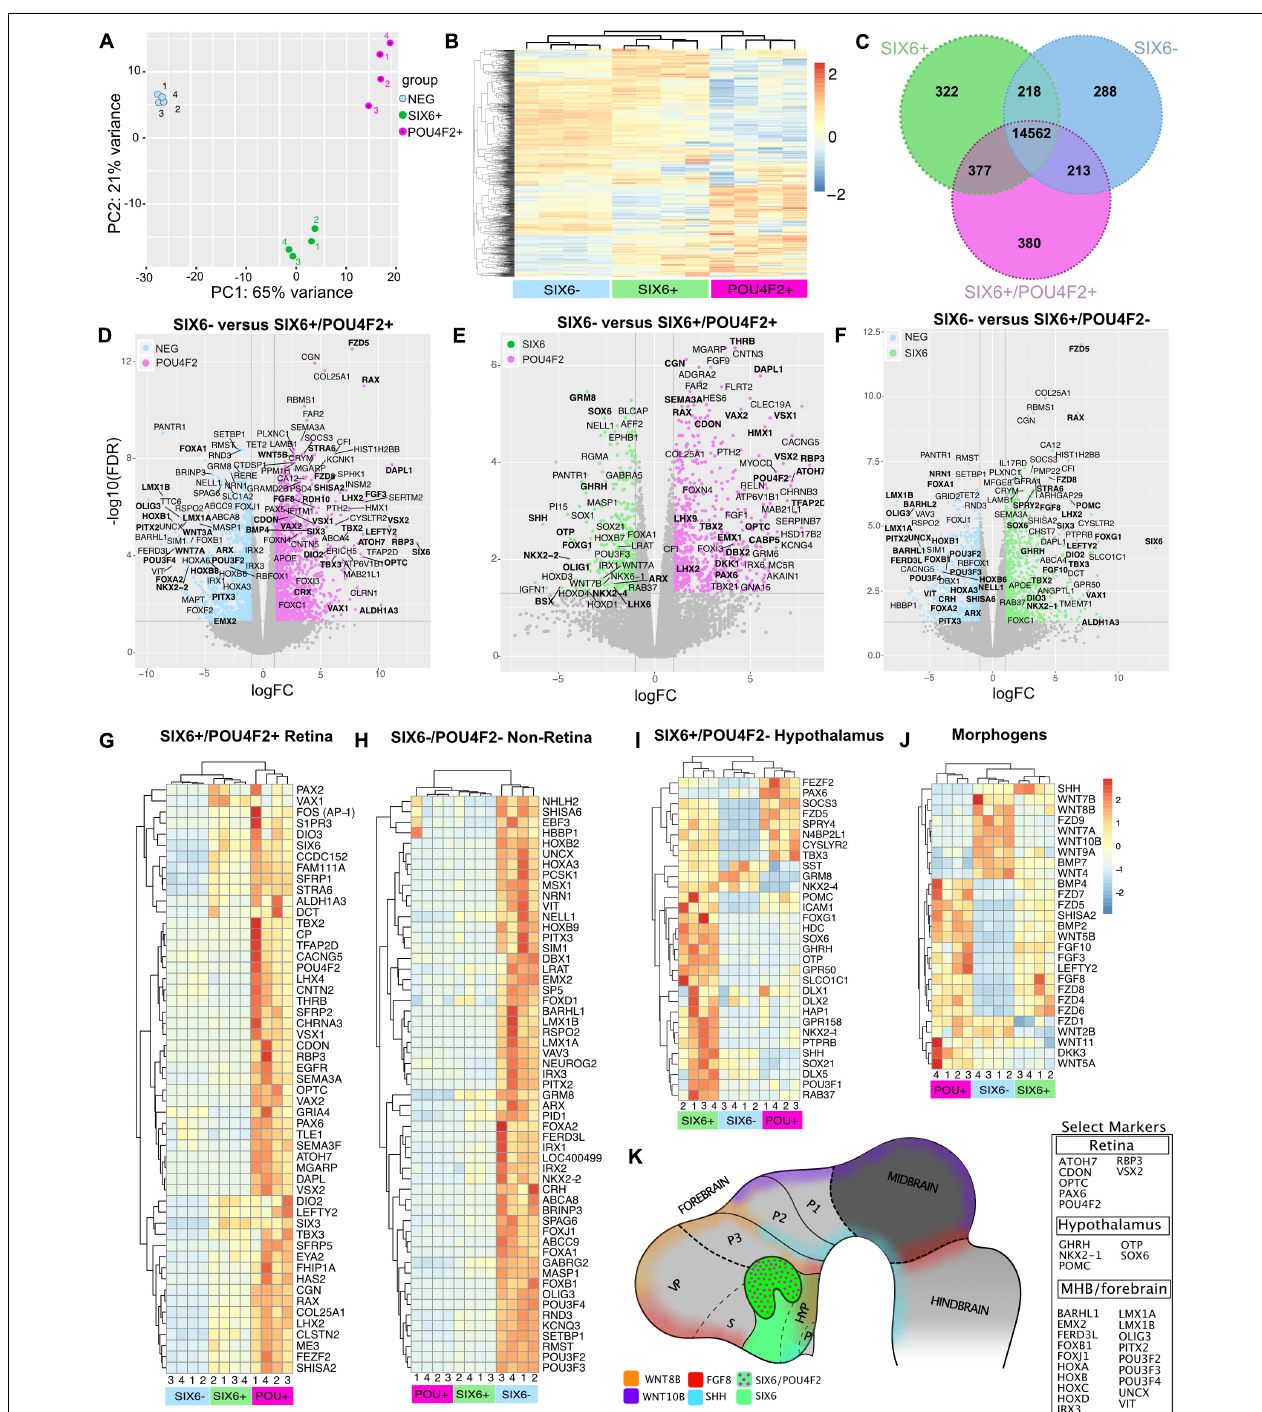
FIGURE 7 | Gene expression signatures in SIX6-, SIX6 +, and SIX6 + /POU4F2 + organoids after 65 days. (A) A PCA plot showing clustering within organoid types. (B) A heatmap of the top 1,000 expressed genes in SIX6 + /POU4F2 + organoids compared with SIX6 + /POU4F2- and SIX6- organoids. (C) A Venn diagram showing the intersection of significant genes expressed by organoid types. (D–F) Volcano plots of significantly different genes between (D) SIX6- and SIX6 + /POU4F2 + organoids, (E) SIX6 + /POU4F2- and SIX6 + /POU4F2 + organoids, (F) and SIX6- and SIX6 + /POU4F2- organoids. Differences plotted as logFC vs. -log10(FDR) with significance set as FDR < 0.5 and a FClog2 > 1. (G–J) Hierarchical clustered heat maps show genes enriched in (G) SIX6 + /POU4F2 + retina, (H) SIX6-/POU4F2- non-retina, (I) SIX6 + /POU4F2- hypothalamic organoids and (J) key developmental morphogens. (K) A conceptual diagram of key markers as diagnostic markers for different brain